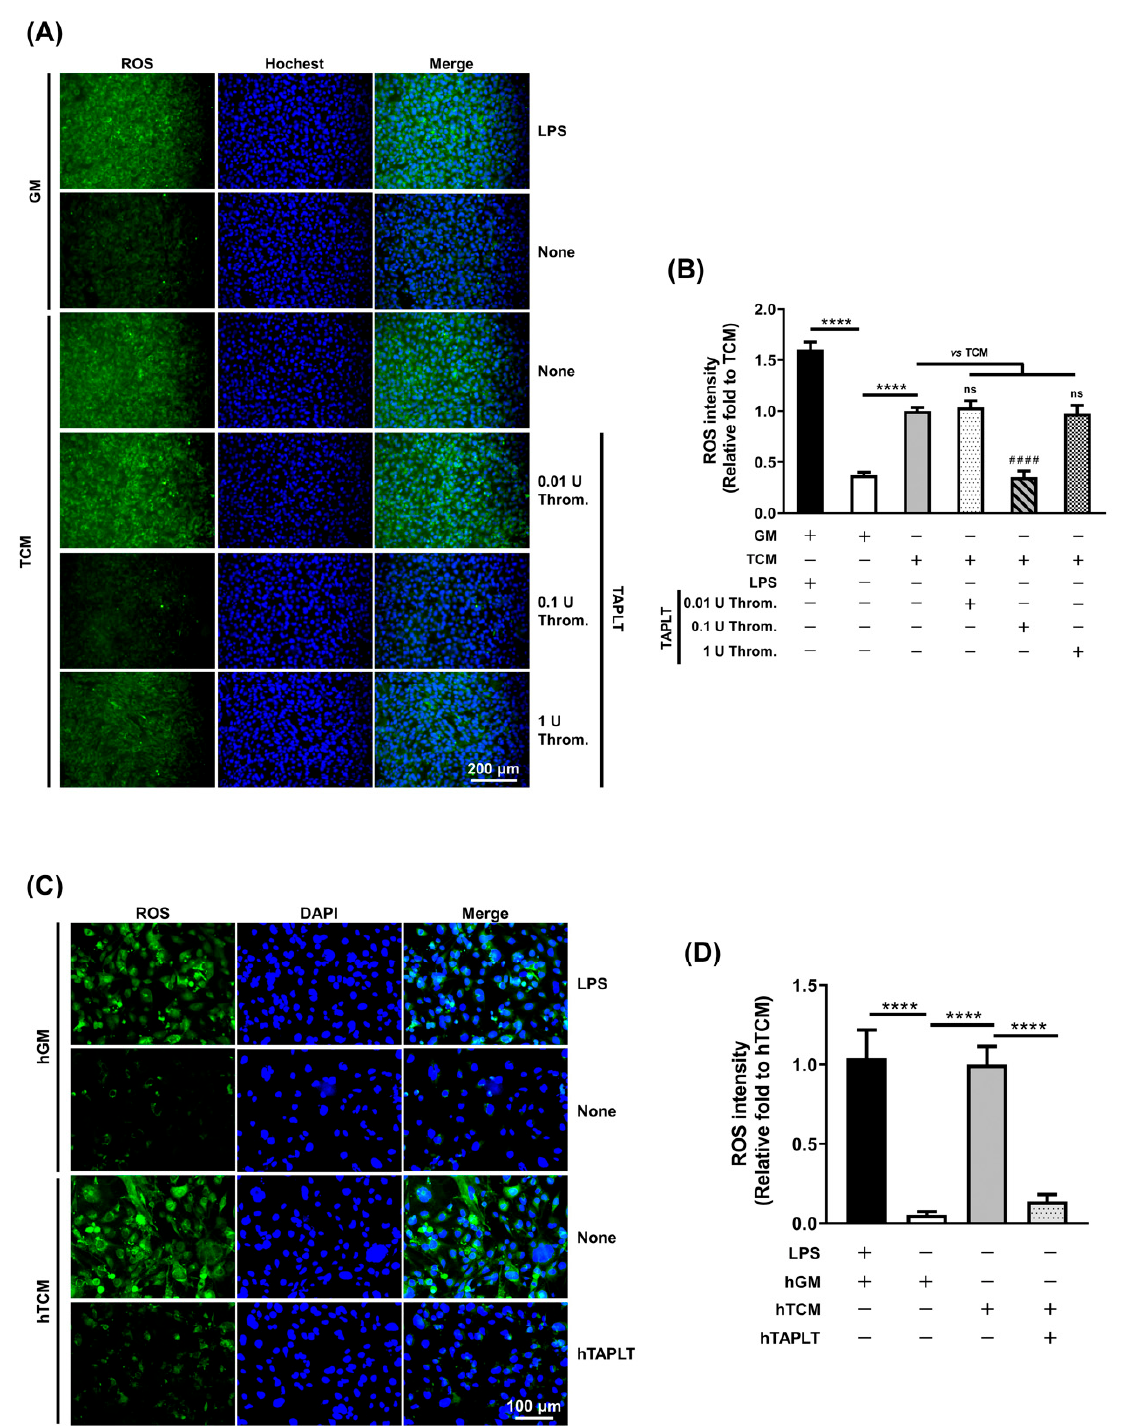
Figure 1. Thrombin-activated platelets (TAPLT) inhibit tumor-induced reactive oxygen species